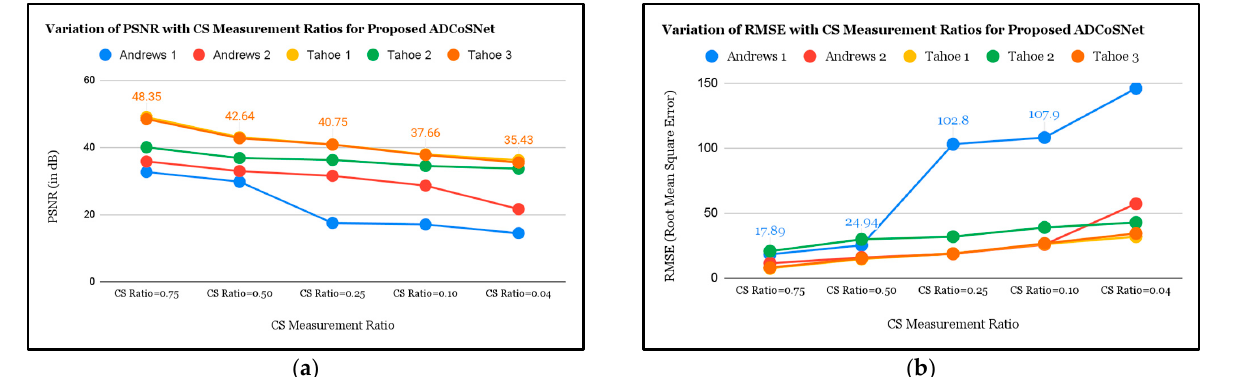
Figure 9. Illustration of variation in ( a ) PSNR and ( b ) RMSE, with varying CS measurement ratios for the selected five samples from the Andrews and Tahoe dataset.